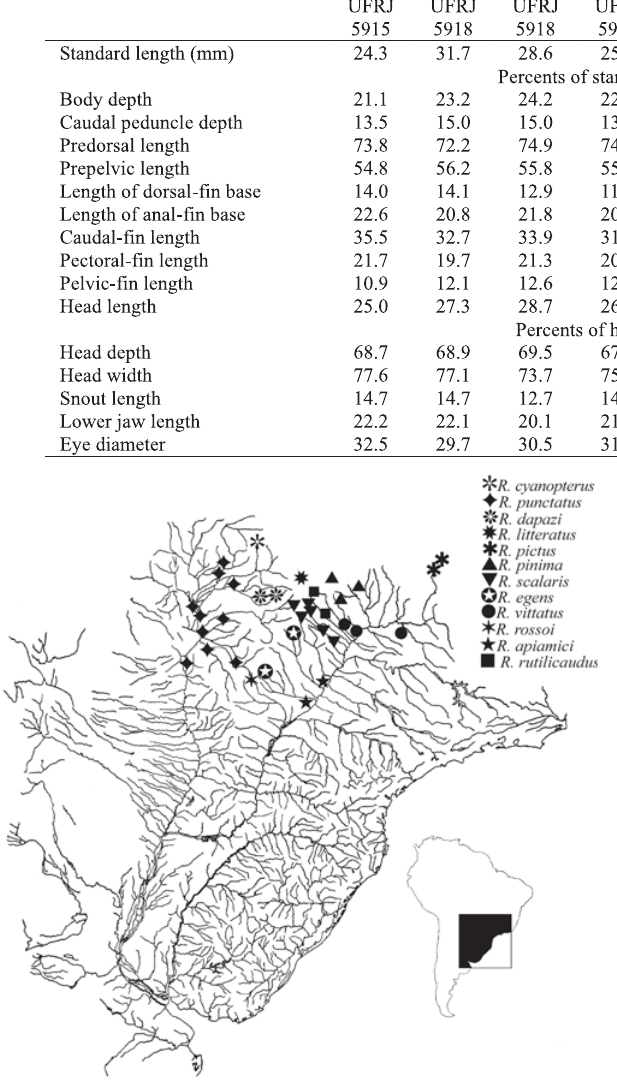
Fig. 2. Geographic distribution of species of the genus Rivulus in the Paraná, Paraguay, and upper Araguaia river basins, central